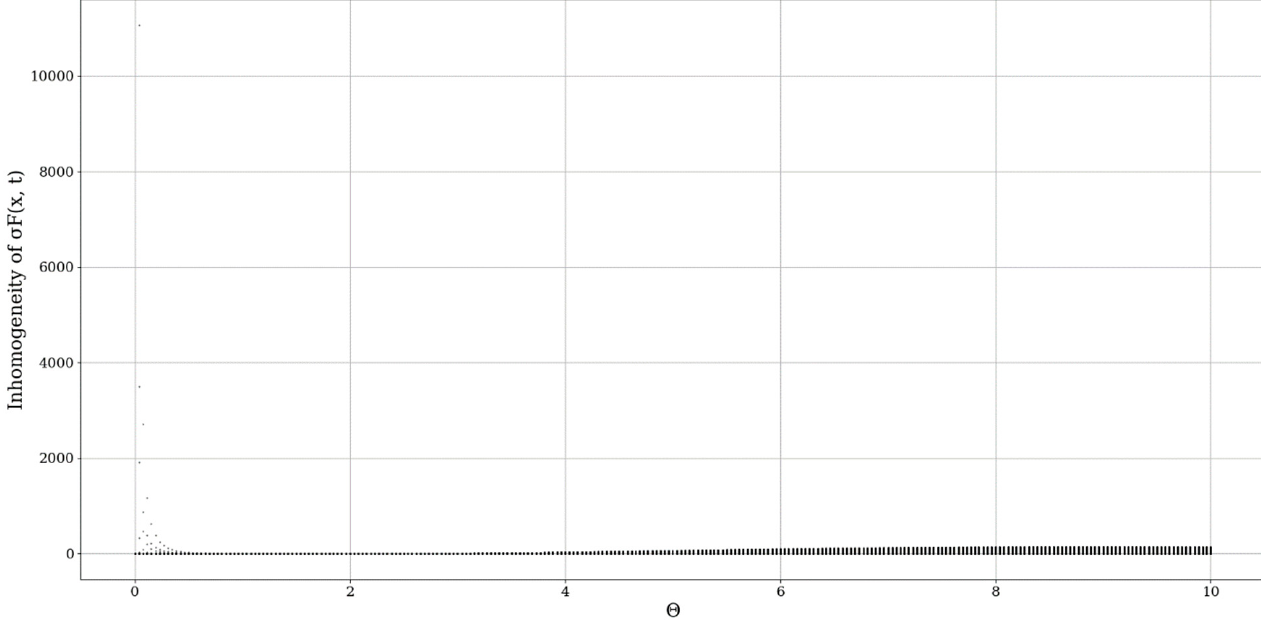
(cid:48) 2 (cid:105) example plot with θ as control parameter; ξ = 3; µ = Figure 12. 〈|σ (cid:2890) (cid:3364)(cid:3364)(cid:3364)| (cid:4593)(cid:2870) 〉 example plot with θ as control parameter; ξ = 3 ; μ = 9 . Figure 12. (cid:104)| σ F |